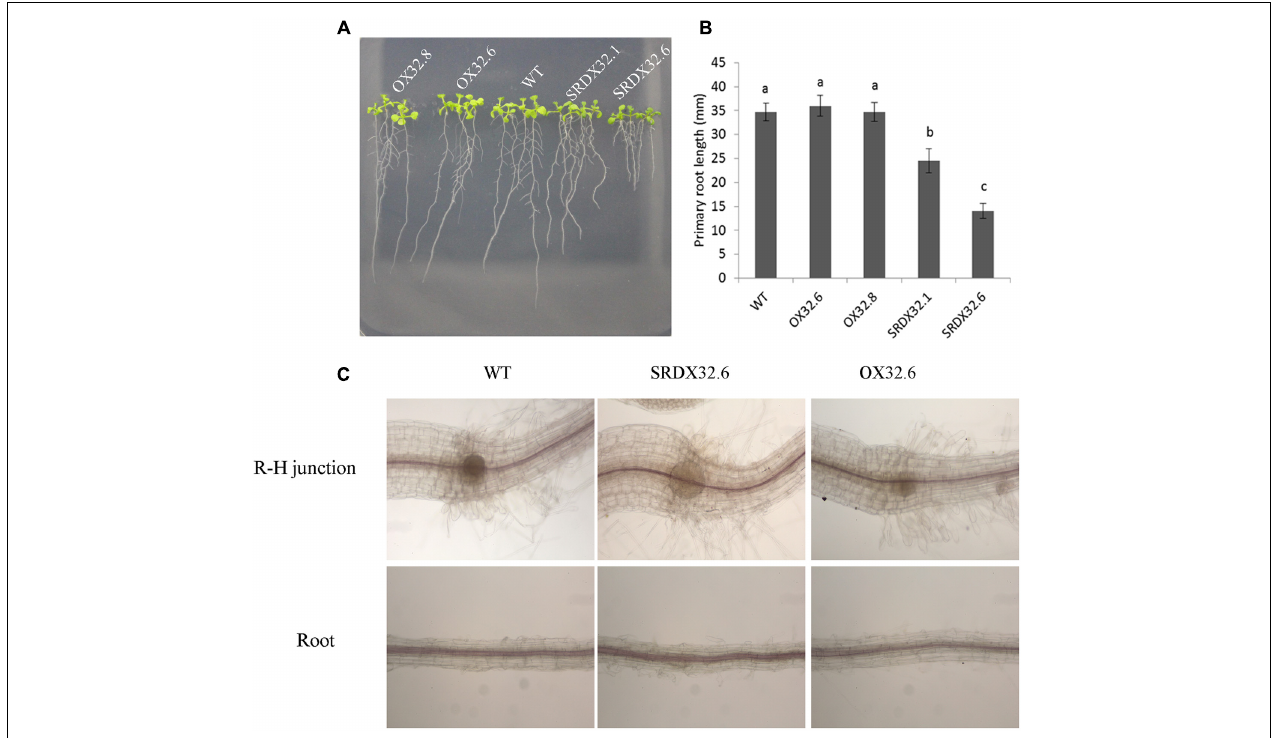
FIGURE 7 | (A) Phenotype of 10-day-old seedlings grown on half-strength MS agar plates supplemented with 1% sucrose under long-day condition. (B) Primary root lengths of 7-day-old seedlings of wild-type and ANAC032 transgenic lines. Data represent values from three biological replicates. Each replicate included 20 roots. Bars with same letters are not statistically different from each other according to one way ANOVA-LSD test ( P < 0.05). (C) Analysis of lignification pattern in WT and ANAC032 transgenic lines. Phloroglucinol-HCl staining of lignin in roots and hypocotyl regions of 7-day-old seedlings. Roots were analyzed under a light microscope (10 X magnification). (R-H, root-hypocotyl